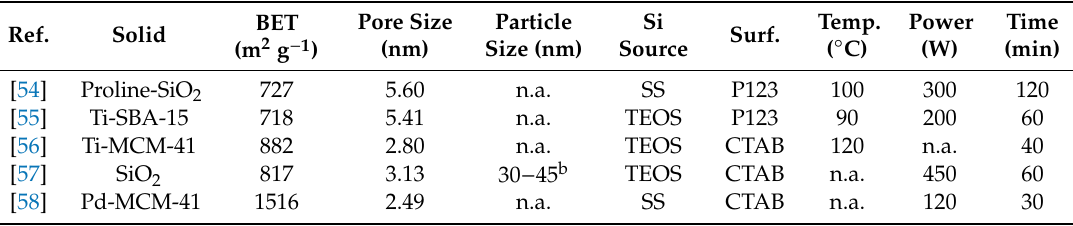
Table 2. Synthesis parameters and characterization of the solids prepared for catalysis, drug release and gas adsorption